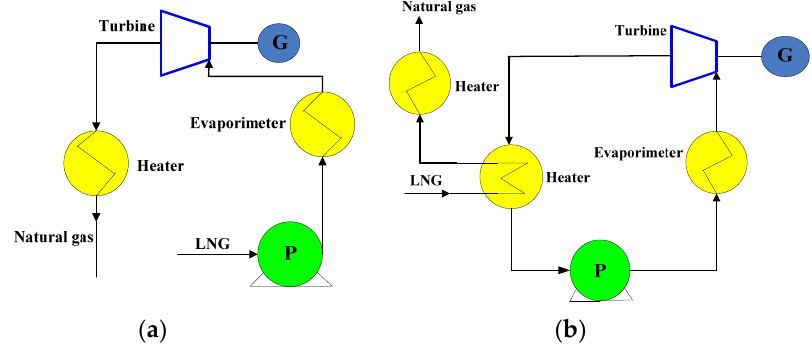
Figure 17. Liquefied Natural Gas (LNG) power generation schematic diagram: ( a ) direct expansion method; ( b ) secondary media method.